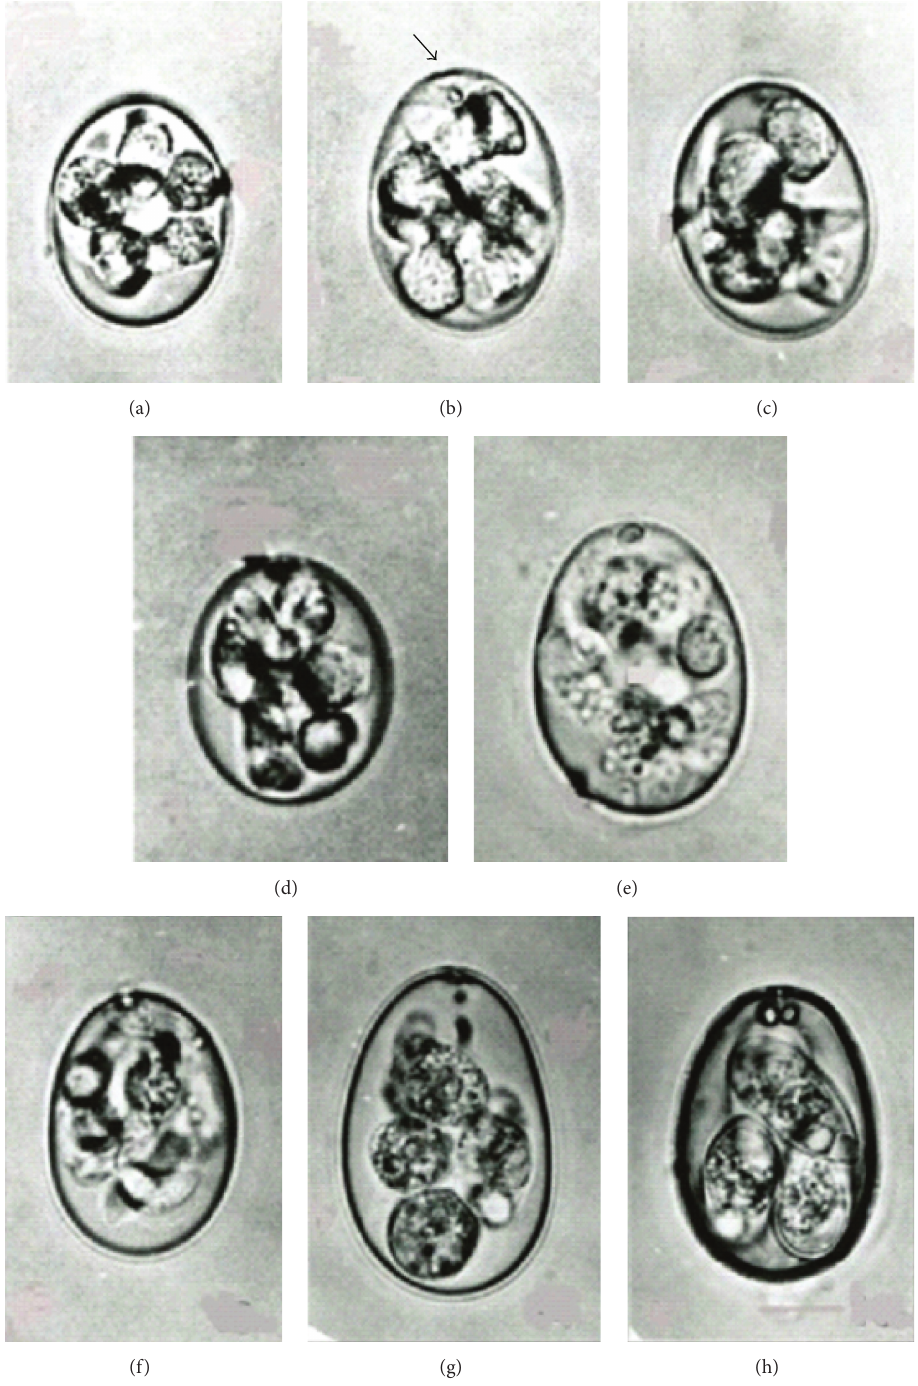
Figure 2: (a–e) Altered organisms (oocysts of E . tenella ) during evolutional stages following procedure at 28 to 44 h (slide representative from over 100 organisms). (a) Altered organisms (oocysts) begin to divide at 28 h × 1,000. (b) Further development showing the polar granule (indicatedbyarrow)at32 h × 1,200.(c)Freesporozoitesformingfromprotoplasmicmassat36 h × 1000.(d)Sporozoitesformationcompleteat 44 h × 1,100. (e) Degenerating altered oocyst of E . tenella 3 months after storage at 4 ∘ C × 1,070. (f–h) Eimeria necatrix and E . maxima following the alteration procedure (slide representative from over 100 organisms). (f) E . necatrix proceeds to altered organism after the procedure to contain free sporozoites × 1,000. (g) E . maxima fail to complete sporulation after the altering procedure. × 800. (h) E . maxima form normal organisms containing 4 sporocysts, each with 2 sporozoites after the procedure. ×